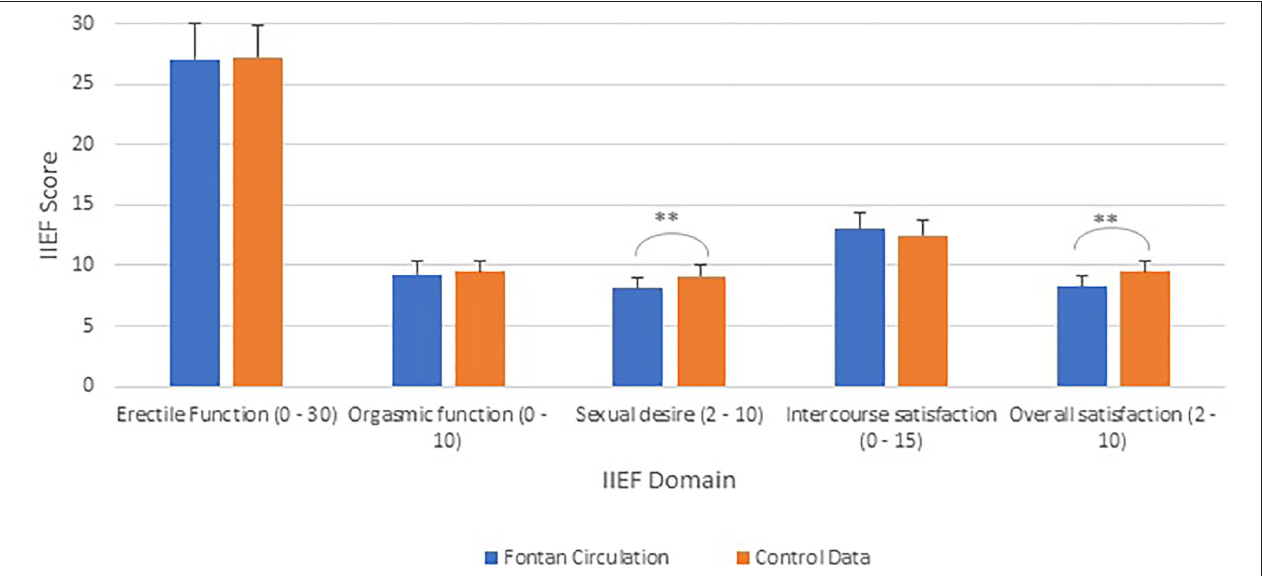
FIGURE 1 | International Index of Erectile Function scores (IIEF) (range) for men with a Fontan compared to reference control data (12). ** p < 0.001.